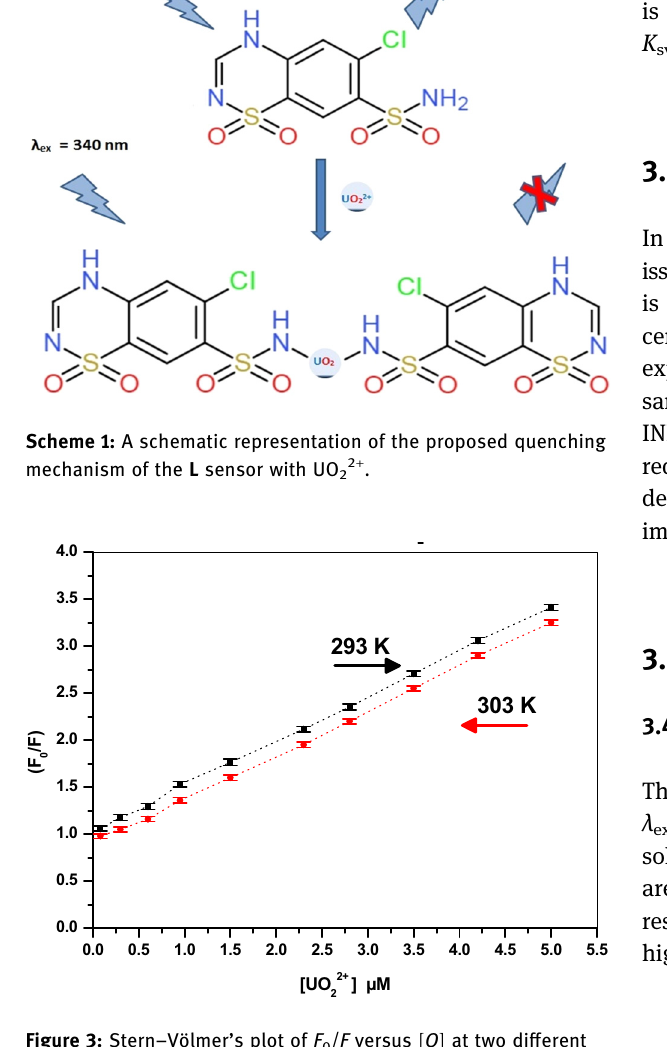
Figure 3: Stern – Völmer ’ s plot of F 0 / F versus [ Q ] at two di ff erent temperatures ( 293 and 303 K ) ( values are mean of fi ve replicates ) , and all the RSD values are less than 2.0%.